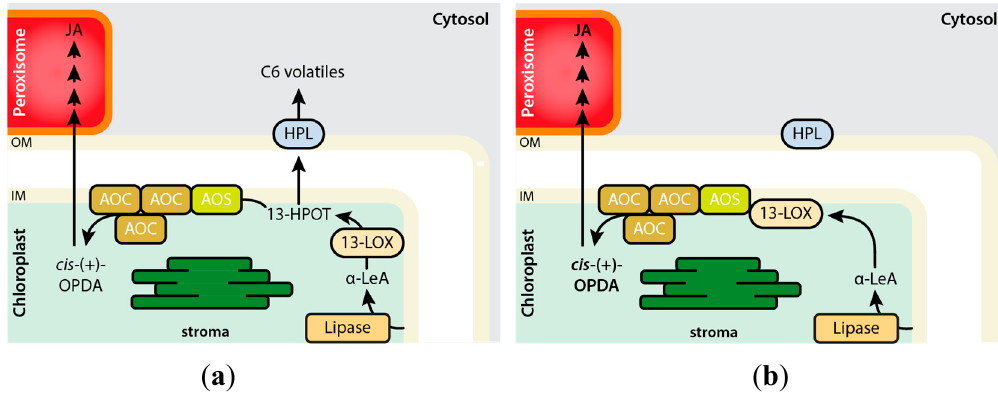
Figure 5. Compartmentalization of the AOS and HPL branches of the Vick and Zimmerman pathway in plants. ( a ) Under unperturbed conditions, the link between LOX2 and AOS is less strong, causing a portion of 13-HPOT to leak out of the enzymatic channel. The free 13-HPOT serves as substrate for HPL to produce green leaf volatiles. ( b ) In response to herbivory, however, the amount of chloroplastic AOS and AOC increases, effectively recruiting LOX2 into the LOX2–AOS–AOC complex. This prevents leakage of 13-HPOT and consequently promotes cis -(+)-OPDA production.